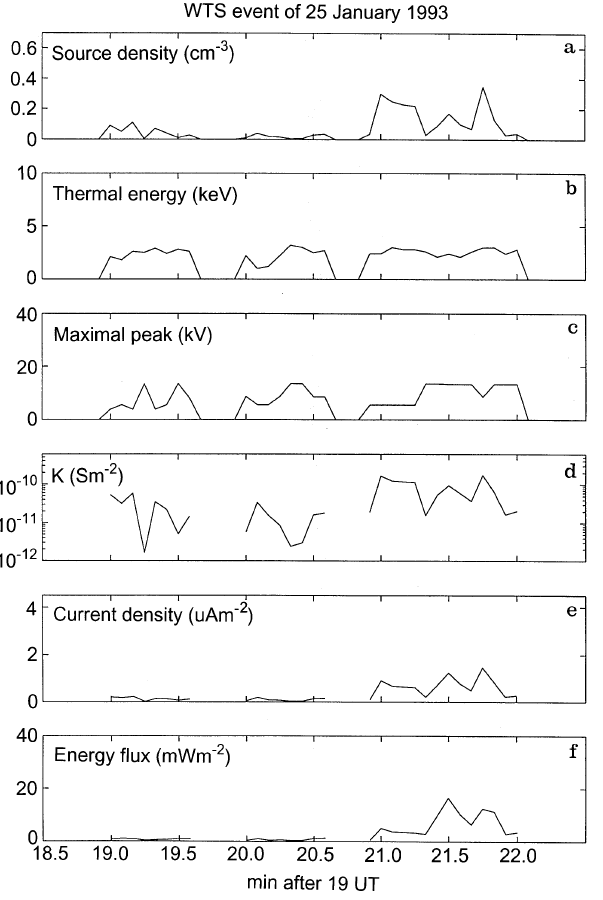
Fig. 6. a Source density, b thermal energy, c field-aligned conduc- tance, d potential drop, e current density and f energy flux esti- mated from each 5-s spectra during the 25 January 1993 event